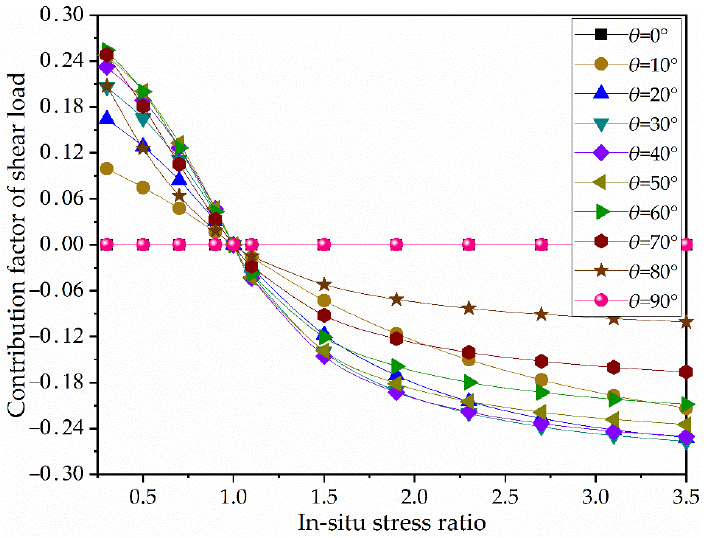
Figure 12. Relationship between the contribution factor of shear load ( CFSL ) and the in-situ stress ratio.